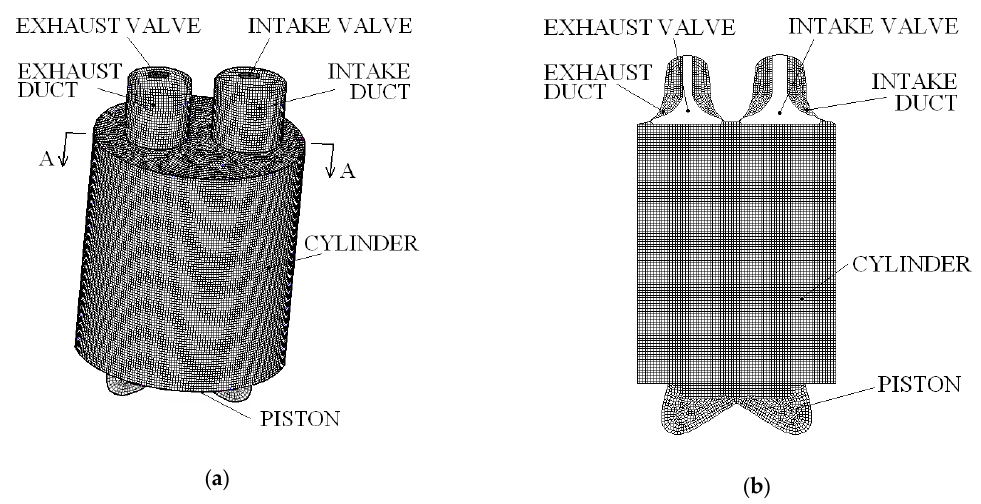
Figure 3. Computational mesh at bottom dead center. ( a ) Tri-dimensional view; ( b ) AA section.